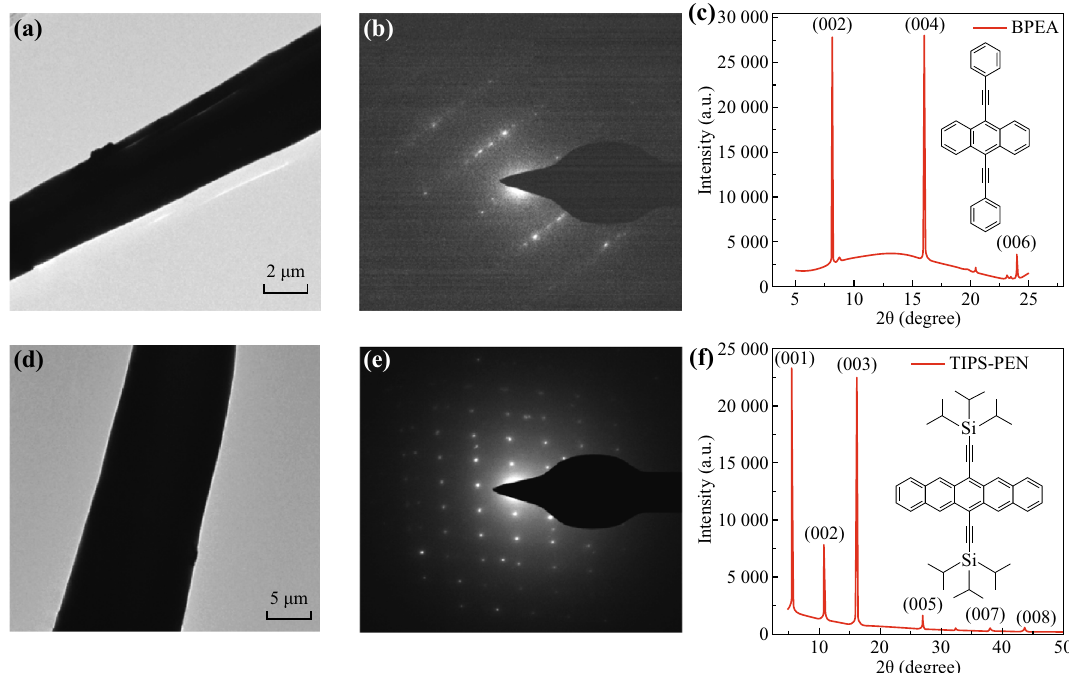
Fig. 2 TEM images of the BPEA nanoribbon ( a ) and TIPS-PEN nanoribbon ( d ). b , e Show the corresponding SAED patterns. c , f XRD patterns of BPEA and TIPS-PEN nanoribbon arrays fabricated on the SiO 2 /Si substrates, respectively. Insets show the molecular structures of BPEA and